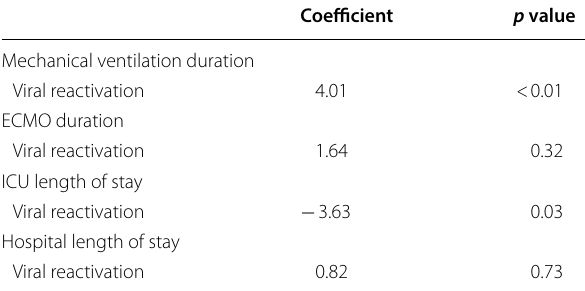
Table 4 Clinical outcomes in HSV, CMV, HSV and CMV (co-reactivation) or non-reactivation groups